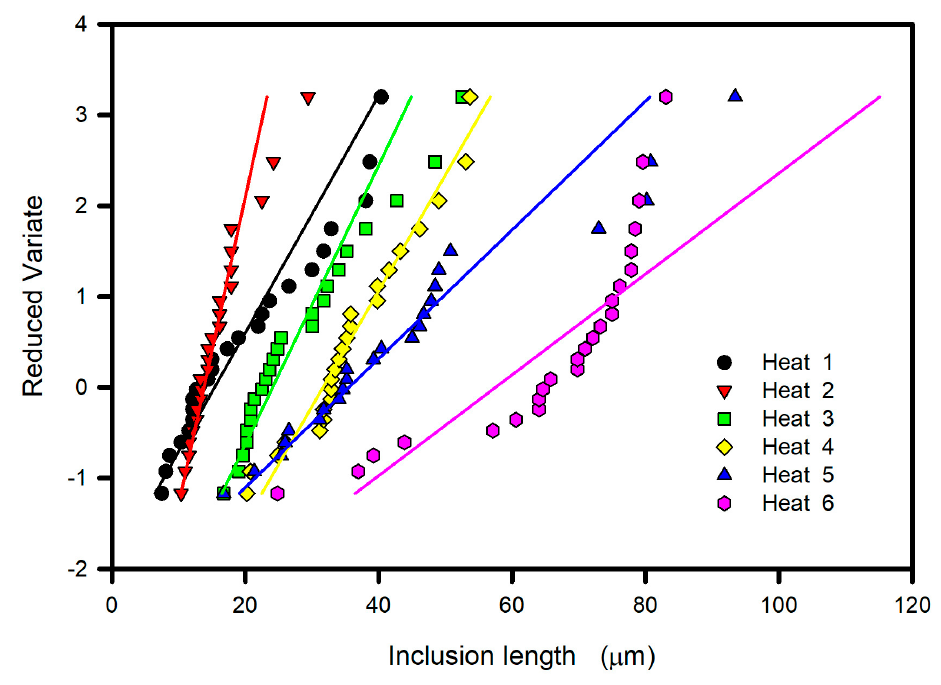
Figure 10. Reduced variate versus inclusion length. Table 3. Values of statistical parameters ( µ